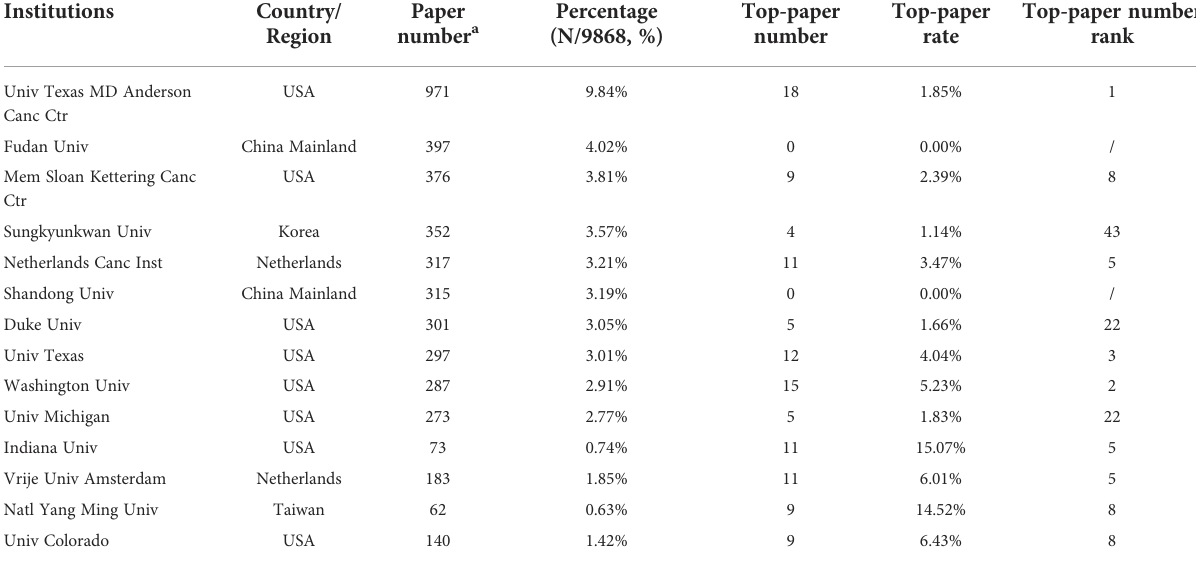
TABLE 5 The top 10 institutions with the most papers or top-papers on lung cancer radiotherapy from 2000 to 2022.